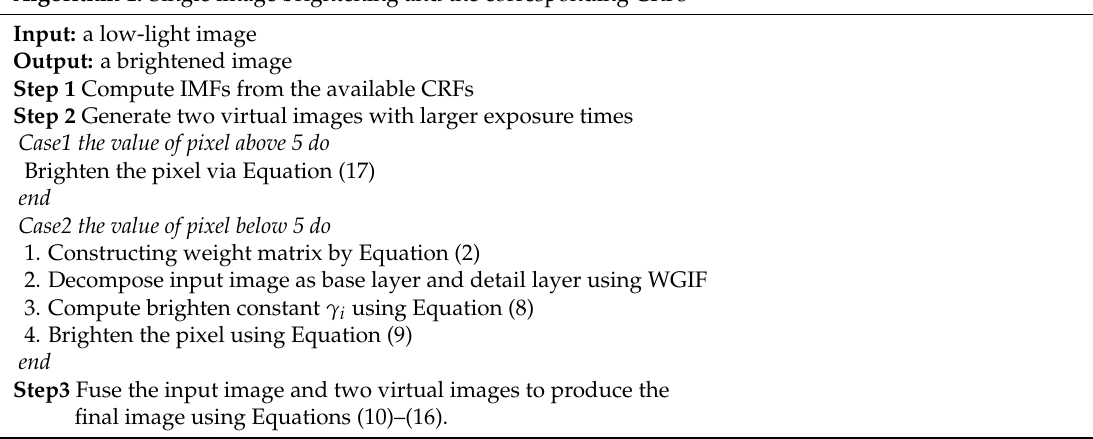
Algorithm 1: Single image brightening and the corresponding